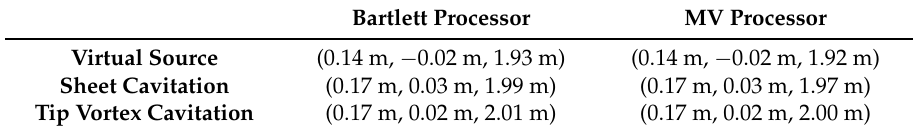
Table 2. Estimated noise source positions p x s , y s , z s q for the propeller cavitation noise experiment.